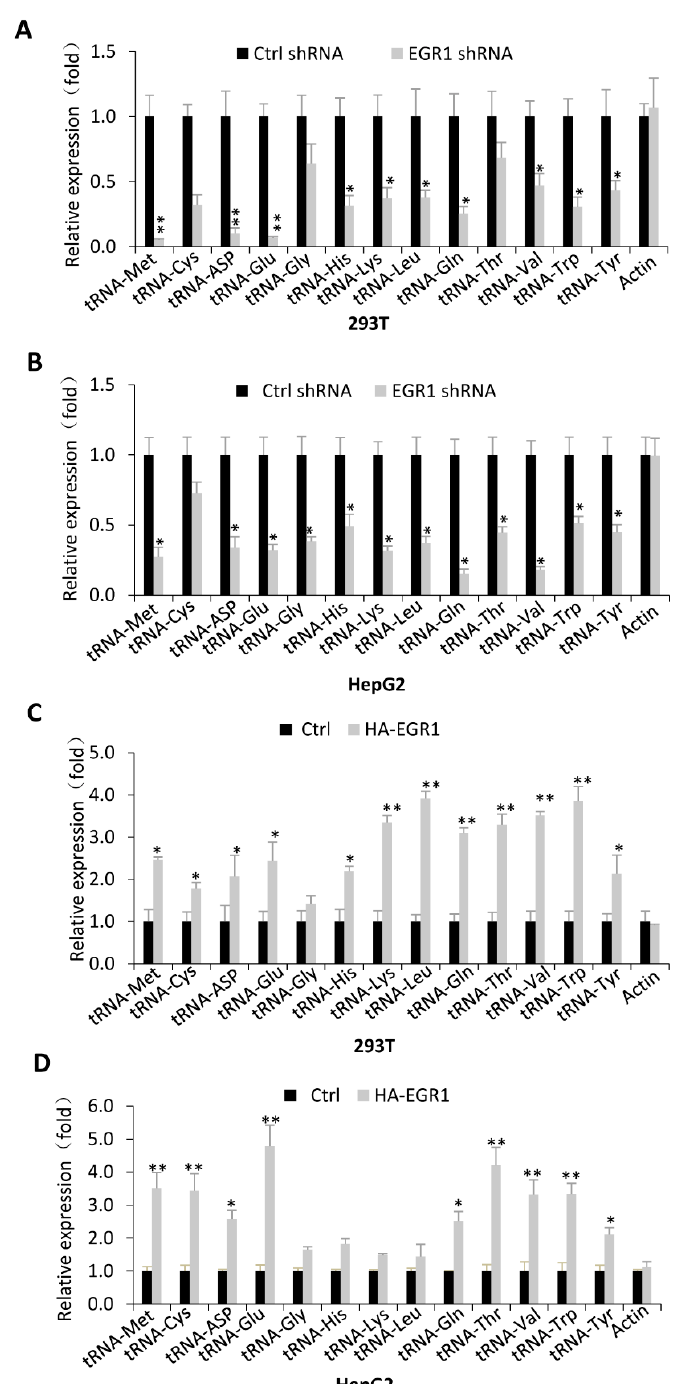
Figure 3. EGR1 positively regulated the expression of most tRNA genes tested in the assays: ( A ) transfer RNA (tRNA) gene expression was analysed by RT-qPCR using 293T cell lines stably expressing EGR1 shRNA and control shRNA; ( B ) expression of tRNA genes in HepG2 cell lines stably expressing EGR1 shRNA or control shRNA was monitored by RT-qPCR. ( C ) RT-qPCR was used to analyse the expression of tRNA genes in a 293T cell line stably expressing HA–GER1 and its control cell line; ( D ) expression of tRNA genes in the HepG2 cell line stably expressing HA–GER1 and its control cell line was detected by RT-qPCR. Each column in graphs represents the mean ± SD of three biological replicates ( n = 3). *, p < 0.05; **, p < 0.01. The p values of different genes were obtained by Student’s t -test, performed with control and treatment